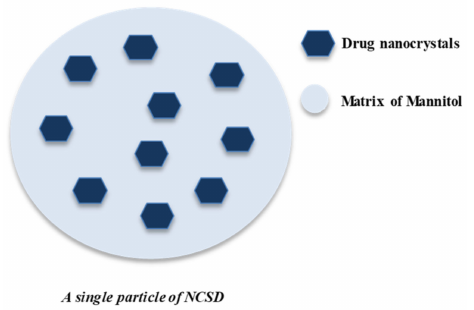
Figure 1. Pictorial representation of Celecoxib Nanocrystalline Solid Dispersion (CEL_NCSD) wherein CEL nanocrystals, stabilized using sodium lauryl sulfate (SLS), are embedded in the matrix of mannitol